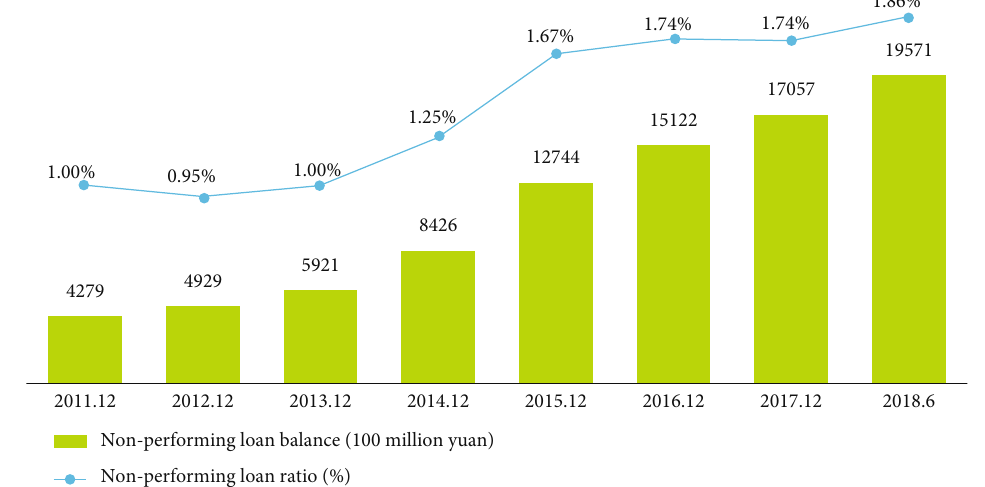
Figure 3: The NPL balance and NPL ratio of Chinese commercial banks from December 2011 to June 2018 fi nancial markets. The relationship between AI + fi nancial industry technology is shown in Figure 4.